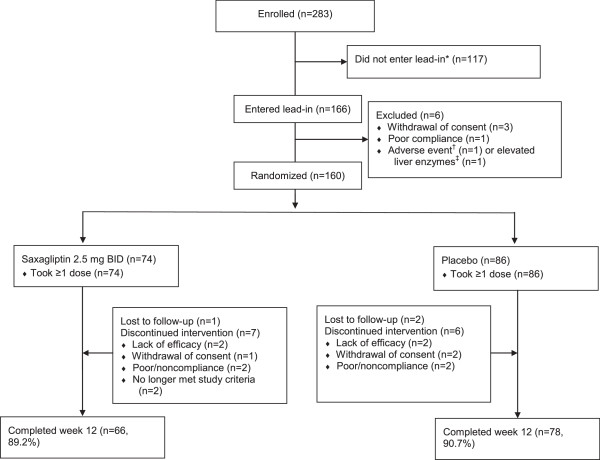
Patient disposition. *Did not satisfy study inclusion and exclusion criteria. †Abdominal pain secondary to partial small bowel obstruction (later classified as a serious AE, requiring hospitalization). ‡Values did not meet the exclusion criteria; however, the investigator chose to withdraw the patient for safety reasons.